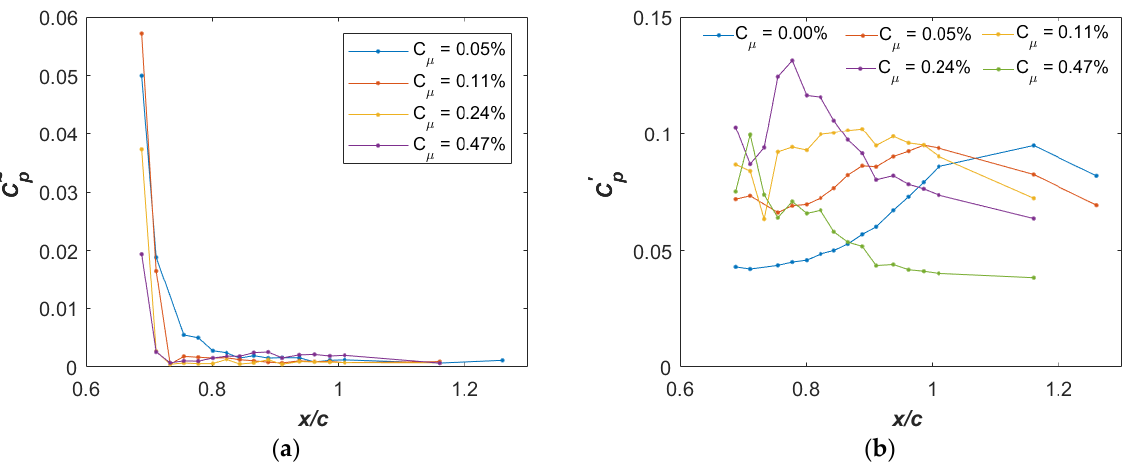
Figure 10. Variation of the fluctuating pressures with respect to the momentum coefficient over the ramp section: ( a ) periodic component; ( b ) random component.